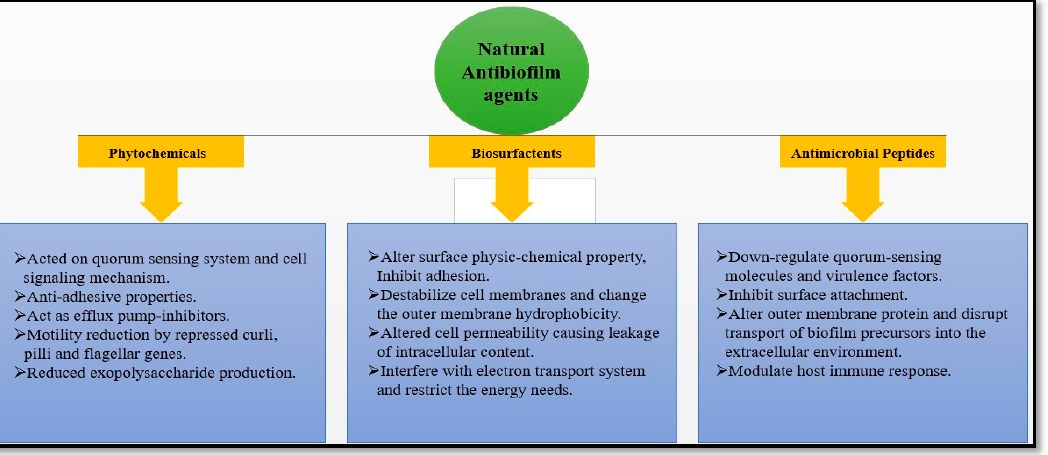
Figure 5. Natural antibiofilm agents based on their mode of action.